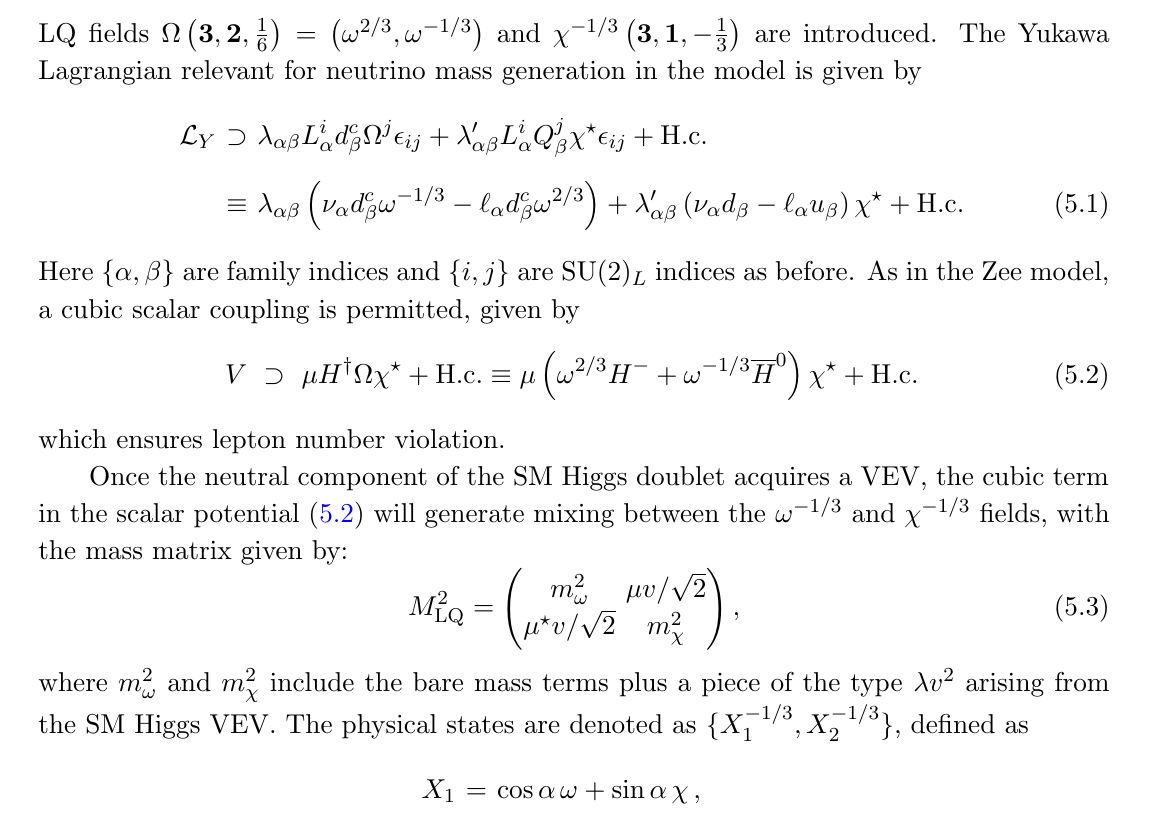
Figure 22 . One-loop diagram inducing neutrino mass in the LQ model. This is the model table 3. In SUSY models with R -parity violation, ! (cid:0) 1 = 3 is identi(cid:12)ed as ~ d and (cid:31) ? 1 = 3 as ~ d c